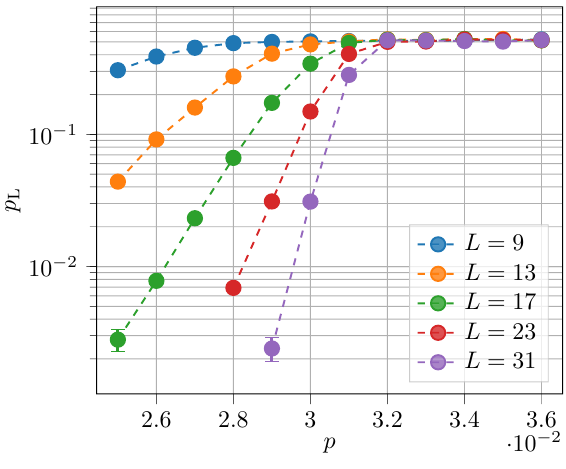
Figure 4. Improving the performance of the sweep decoder applied to the toric code on the rhombic dodecahedral lattice (with boundaries) by applying the rule multiple times per syndrome measurement. We set α = q / p = 1 and we fix N = 2 10 error correction cycles. We plot the logical error rate p L as a function of p for different linear lattice sizes L . We applied the rule three times per syndrome measurement and we observe an error threshold of p th ≈ 3.2% , an improvement of over the corresponding error threshold of p th ≈ 2.17% when we applied the rule once per syndrome measurement (see the inset of Fig. 1a). We use 10 4 Monte Carlo samples for each point.